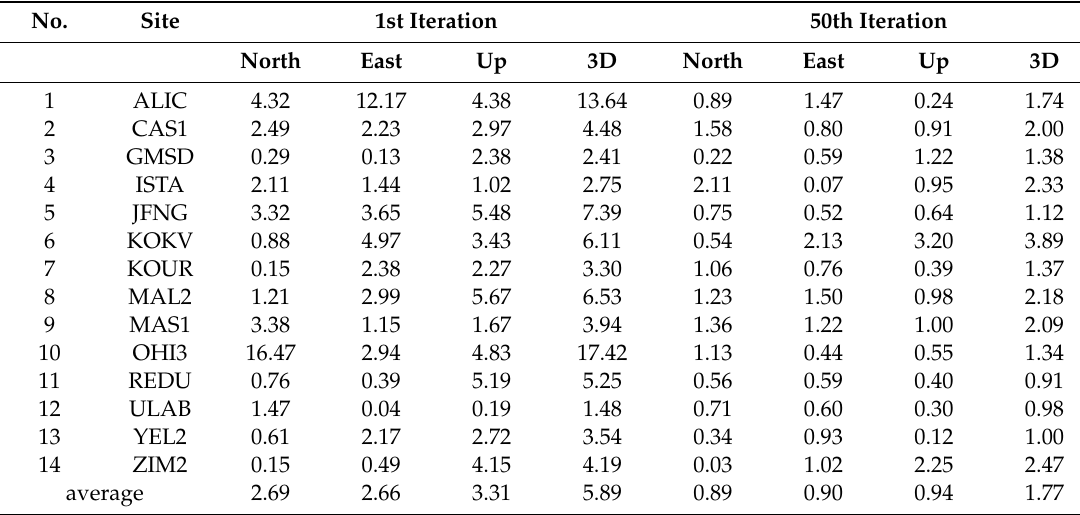
Table 3. Statistics of EM-PPP absolute positioning errors (cm) with respect to IGS stations solution. All sites except YEL2 are processed using multiple GNSS observations. YEL2 is processed using only GPS data to verify the algorithm for single GNSS constellation. The ambiguities are not fixed.